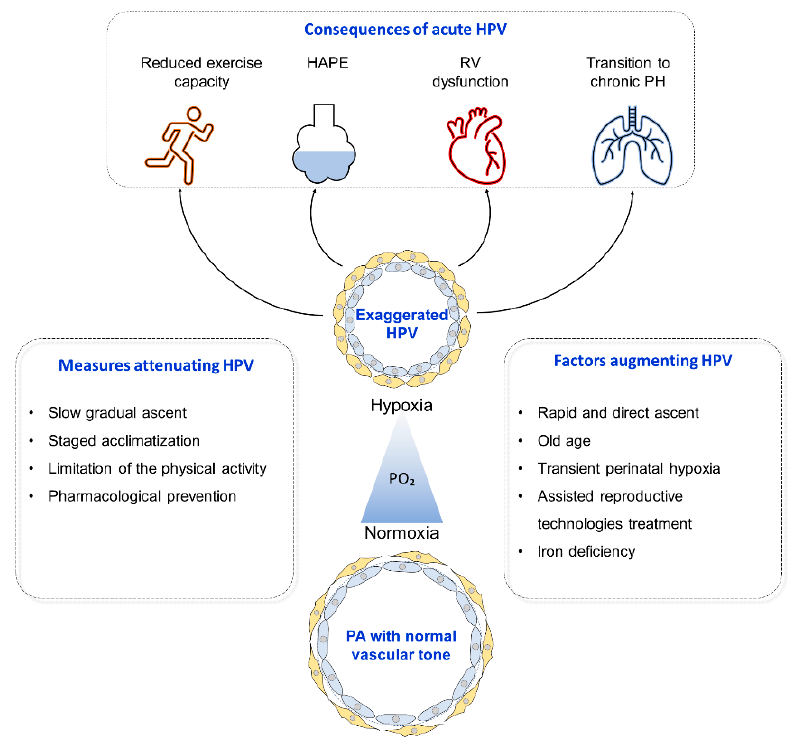
Figure 1. Hypoxic pulmonary vasoconstriction. Hypoxic pulmonary vasoconstriction (HPV) is characterized by constriction of resistive pulmonary arteries (PA) upon exposure to hypoxia. Several factors have been shown to augment HPV, such as rapid and direct ascent to high altitude (HA), old age, transient perinatal hypoxia, assisted reproductive treatment, and iron deficiency. Some measures have been shown to attenuate HPV, such as slow gradual ascent, staged acclimatization, limitation of physical activity, and pharmacological prevention. Exaggerated HPV has been shown to result in several adverse consequences, including reduced physical activity, high altitude pulmonary edema (HAPE) development, right ventricular (RV) dysfunction, and, in the case of prolonged stay at hypoxic condition, HPV may transit to chronic pulmonary hypertension